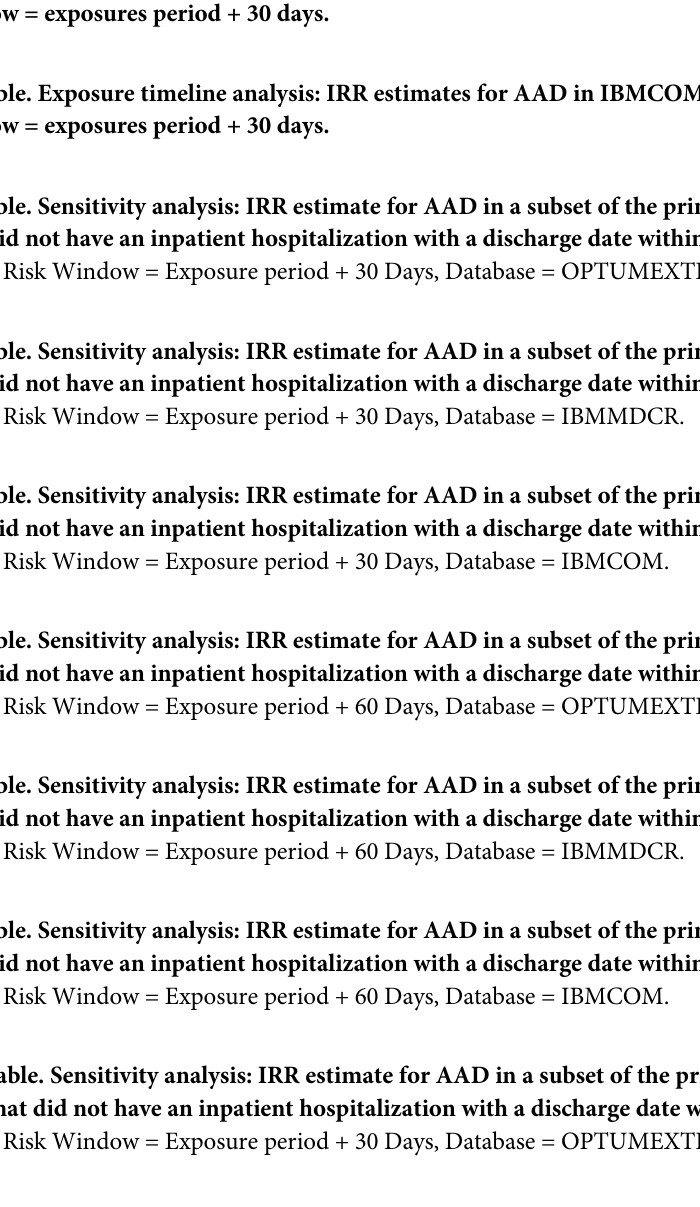
S1 Table. Exposure timeline analysis: IRR estimates for AAD in OPTUMEXTDOD; risk window = exposures period + 30 days. S2 Table. Exposure timeline analysis: IRR estimates for AAD in IBMMDCR; risk window = exposures period + 30 days. S3 Table. Exposure timeline analysis: IRR estimates for AAD in IBMCOM; risk window = exposures period + 30 days. S4 Table. Sensitivity analysis: IRR estimate for AAD in a subset of the primary population that did not have an inpatient hospitalization with a discharge date within 30 days of AAD. Risk Window = Exposure period + 30 Days, Database = OPTUMEXTDOD. S5 Table. Sensitivity analysis: IRR estimate for AAD in a subset of the primary population that did not have an inpatient hospitalization with a discharge date within 30 days of AAD. Risk Window = Exposure period + 30 Days, Database = IBMMDCR. S6 Table. Sensitivity analysis: IRR estimate for AAD in a subset of the primary population that did not have an inpatient hospitalization with a discharge date within 30 days of AAD. Risk Window = Exposure period + 30 Days, Database = IBMCOM. S7 Table. Sensitivity analysis: IRR estimate for AAD in a subset of the primary population that did not have an inpatient hospitalization with a discharge date within 30 days of AAD. Risk Window = Exposure period + 60 Days, Database = OPTUMEXTDOD. S8 Table. Sensitivity analysis: IRR estimate for AAD in a subset of the primary population that did not have an inpatient hospitalization with a discharge date within 30 days of AAD. Risk Window = Exposure period + 60 Days, Database = IBMMDCR. S9 Table. Sensitivity analysis: IRR estimate for AAD in a subset of the primary population that did not have an inpatient hospitalization with a discharge date within 30 days of AAD. Risk Window = Exposure period + 60 Days, Database = IBMCOM. S10 Table. Sensitivity analysis: IRR estimate for AAD in a subset of the primary popula- tion that did not have an inpatient hospitalization with a discharge date within 60 days of AAD. Risk Window = Exposure period + 30 Days, Database =